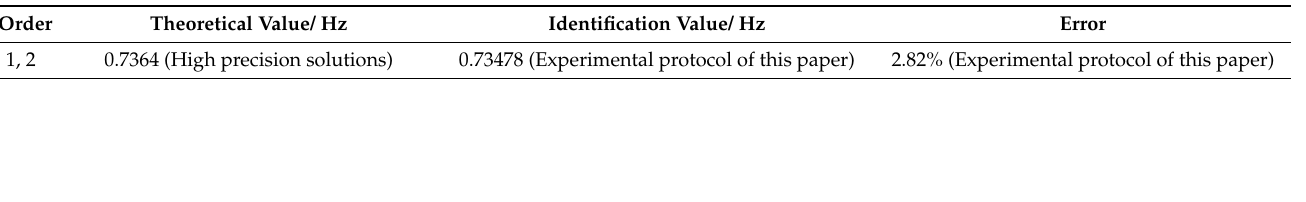
Table 6. Modal recognition results.